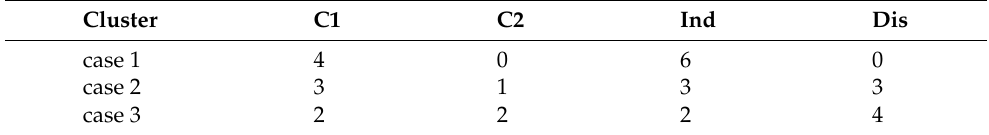
Table A3. Five possible clusterings with cluster number as 2. “IND”: the number of indistinguishable pairwise comparisons; “DIS”: the number of distinguishable pairwise comparisons.